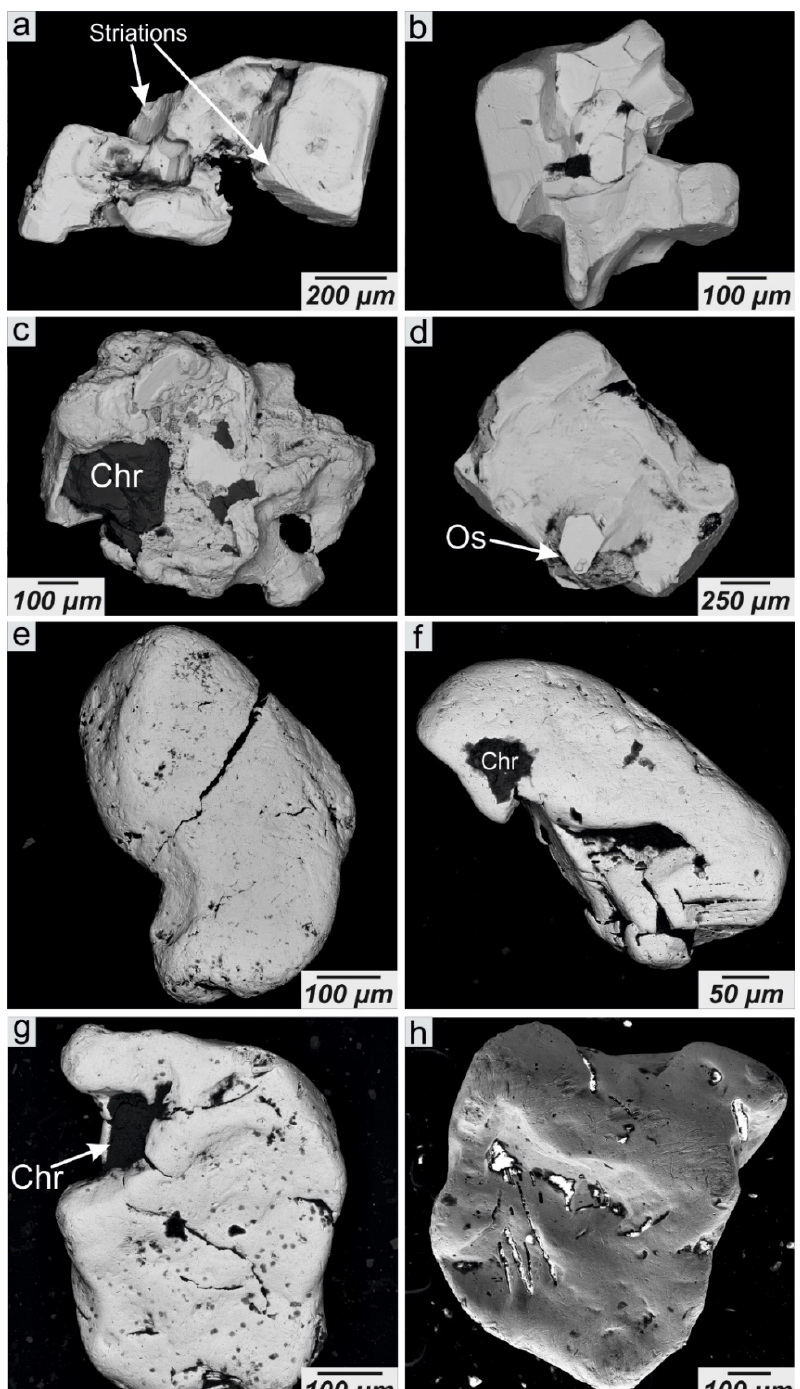
Figure 5. Morphological features of Pt-Fe alloy grains from the Travyanistyi proximal placer ( a – d ) and Glubokinskoe distal placer ( e – h ). Os—osmium, Chr—chromite. BSE images (SEM).